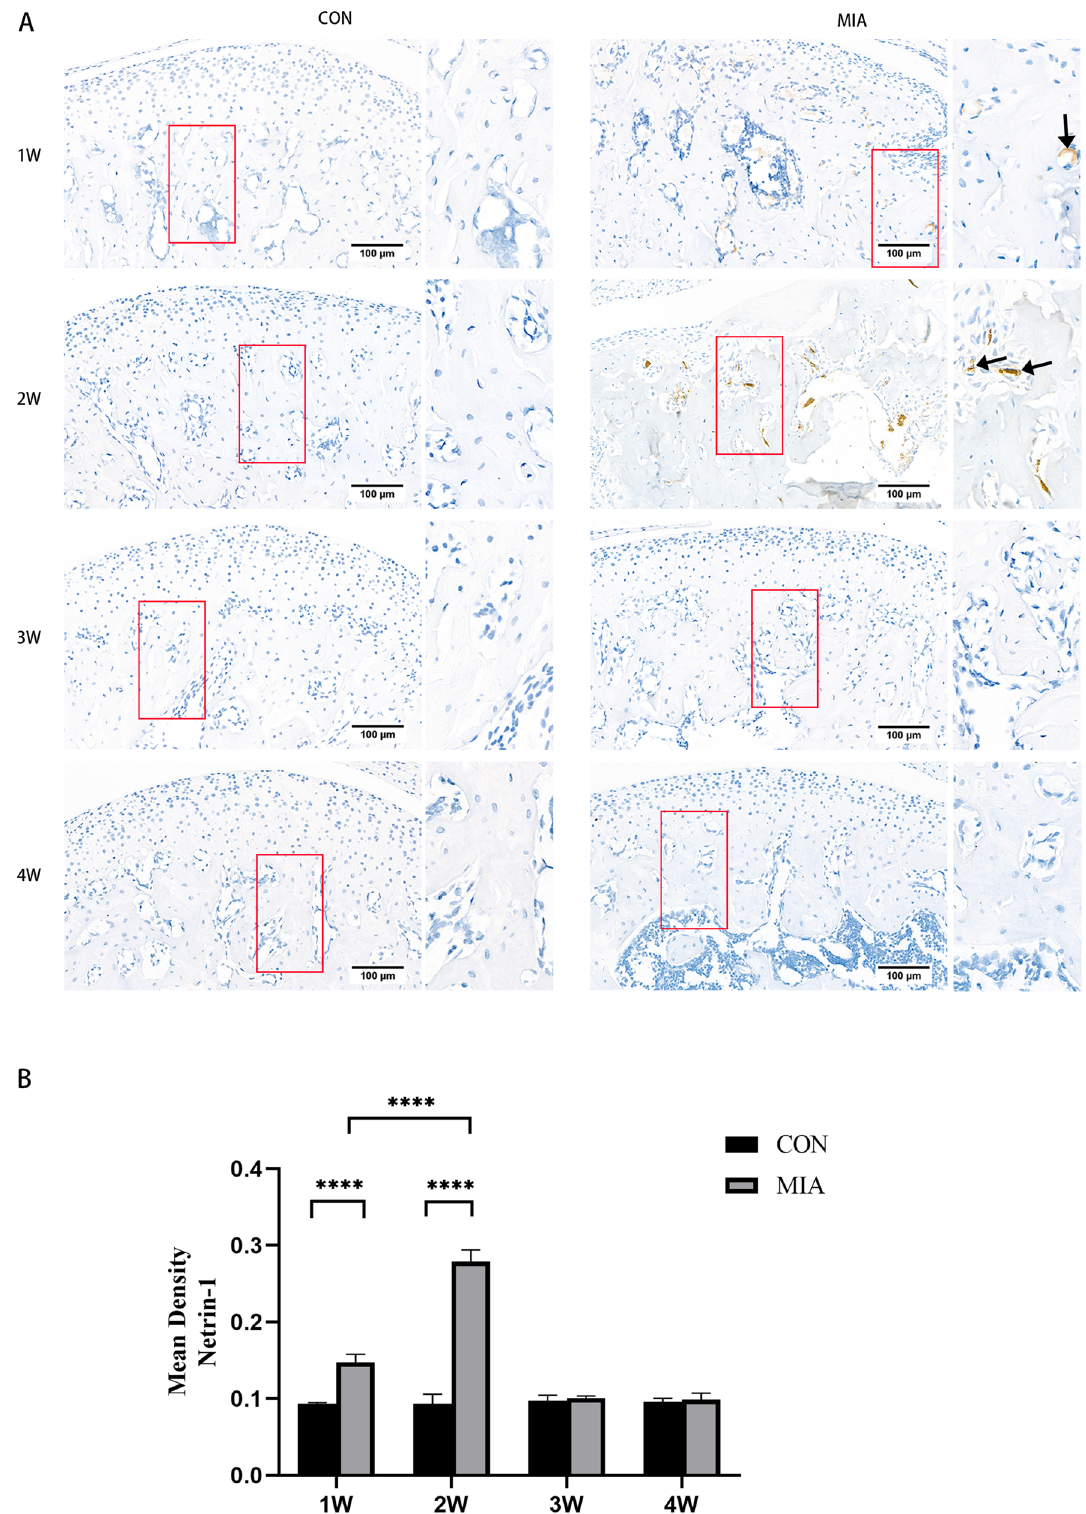
Figure 4. (A) Immunohistochemical staining of Netrin-1 in the TMJ. (B) Quantitative analysis of the density of Netrin-1 in subchondral bone marrow. CON control group (n = 5). MIA: TMJ OA model group (n = 5). **** P < 0.0001. Arrow: Netrin-1 expression